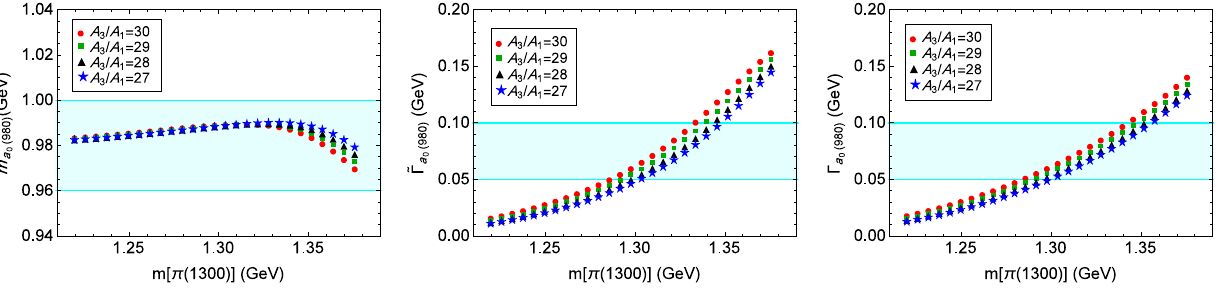
Fig. 15 Predicted physical mass (left) and decay width (middle) of the a 0 ( 980 ) resulted from the first pole position in the unitarized πη elastic scatteringamplitudearecomparedwiththecorrespondingexperimental